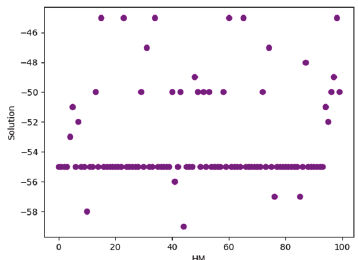
Fig. 8. Diversity of solution vector in HM after 1000 th iteration